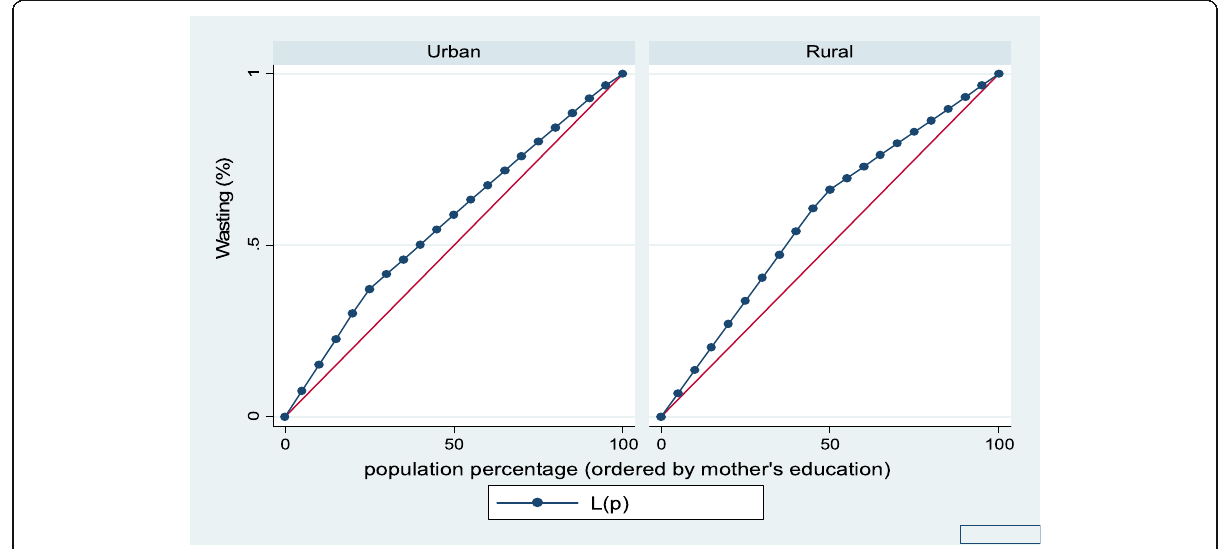
Fig. 8 Urban-rural Lorenz curve for